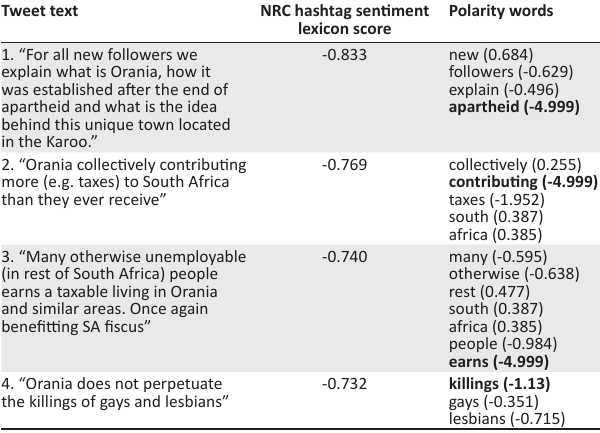
TABLE 9: Positive tweets with negative sentiments. Tweet